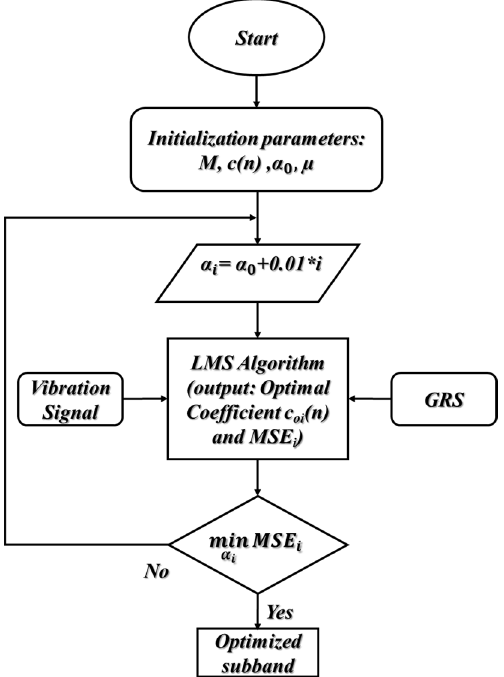
Figure 10. The algorithm flow chart of the ANR-GRS module.